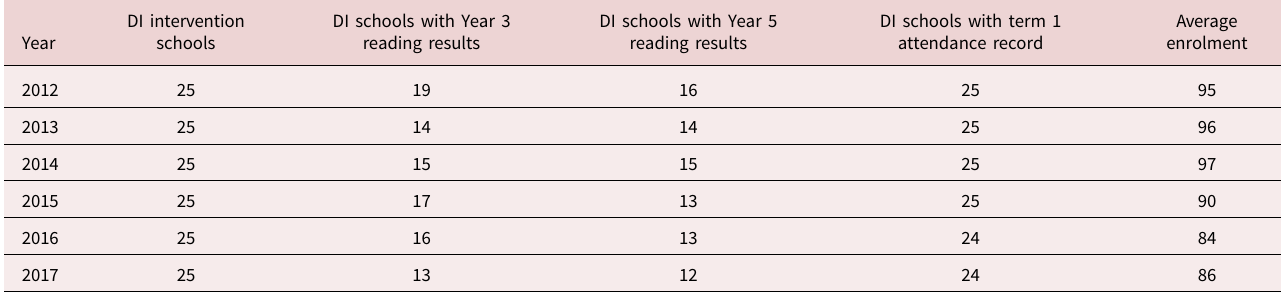
Table 1. Very Remote DI intervention schools with >80% Aboriginal and Torres Strait Islander student enrolments DI intervention Year schools